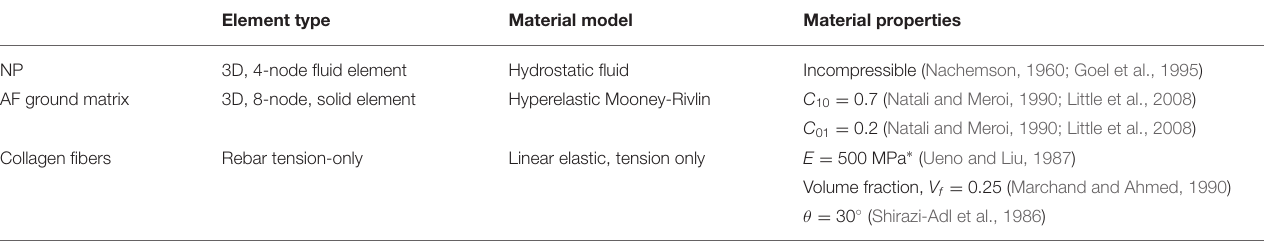
TABLE 1 | Elements, constitutive models, and properties of the